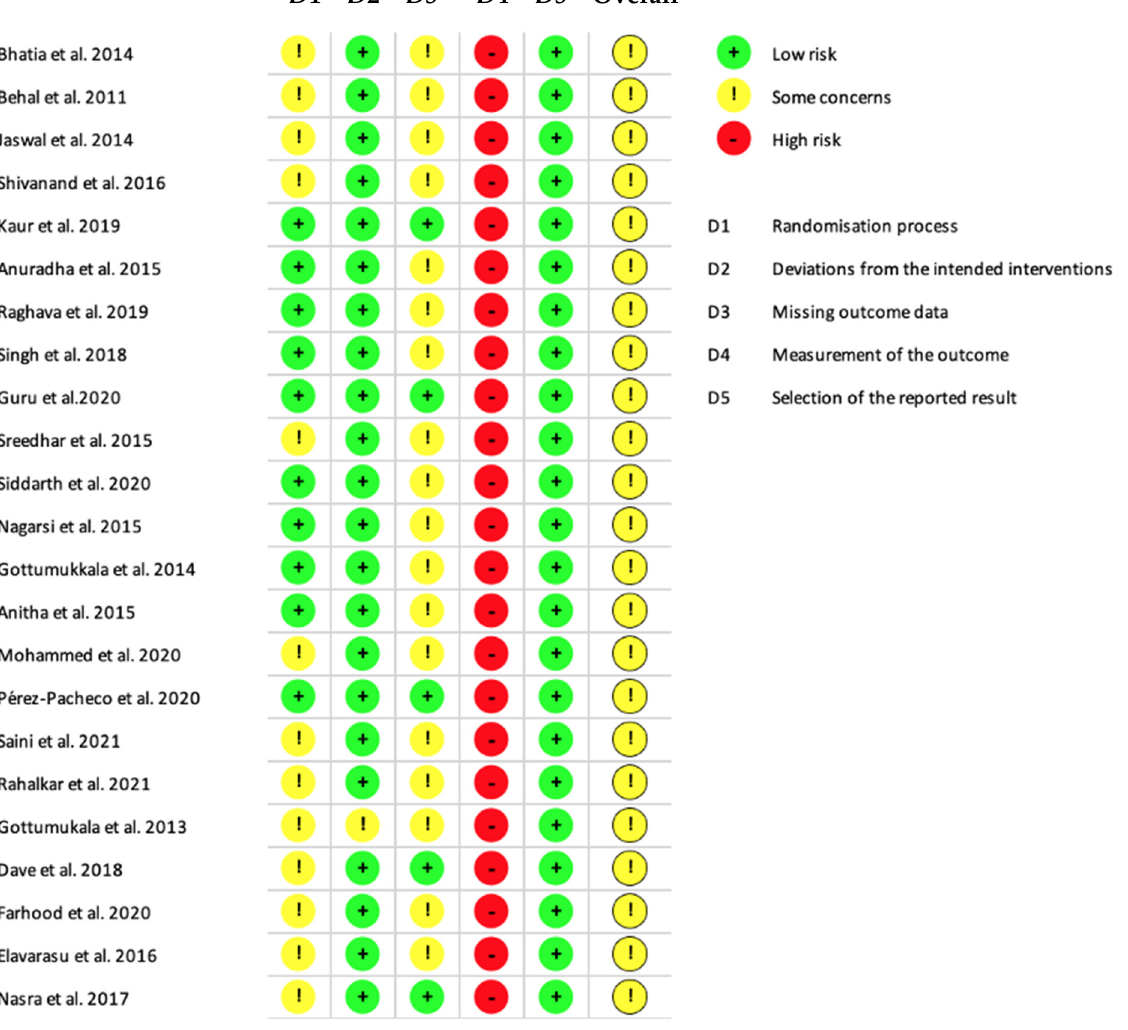
Figure 2. Diagram showing the bias detected in the different domains and overall bias of studies included [31–53]. Based on Sterne et al. (2019) [59].